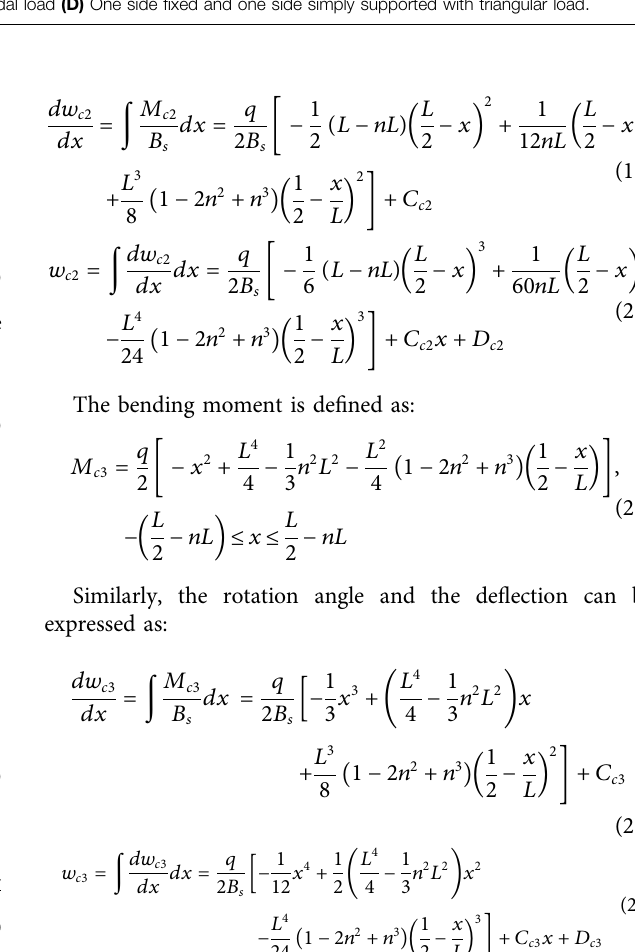
FIGURE 7 | Load distribution of the beams under different constraints (A) Two sides simply supported with trapezoidal load (B) Two sides simply supported with triangular load (C) One side fi xed and one side simply supported with trapezoidal load (D) One side fi xed and one side simply supported with triangular load.